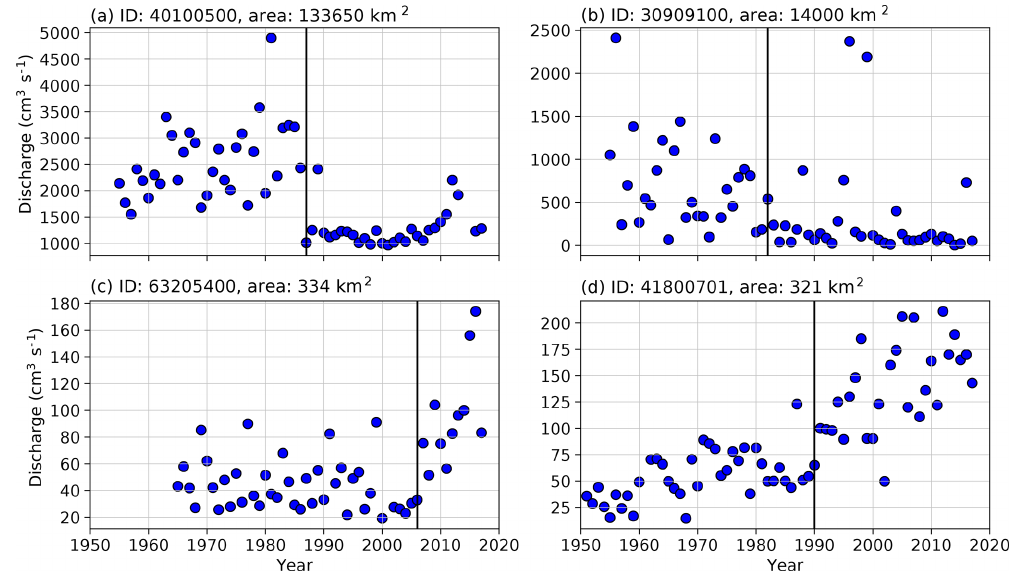
Figure 4. Time series of annual flood peaks for four stream gauging stations with strong human interventions: (a) large hydroelectric dams (upper Yellow River, ID: 40100500), (b) a cascade of small reservoirs (upper Hai He, ID: 30909100), (c) urbanization (a tributary in the lower Yangtze River, ID: 63205400), and (d) a transboundary water-transfer project (a tributary in the lower Yellow River, ID: 41800701). Locations of the four stations are represented by the numbers in brackets in Fig. 3, with (1) to (4) corresponding to (a–d) , respectively. Black lines indicate the year of the occurrence for the change point in mean. Results are based on Pettitt’s test. Only shown are stations with statistically significant Pettitt’s test results (at the level of